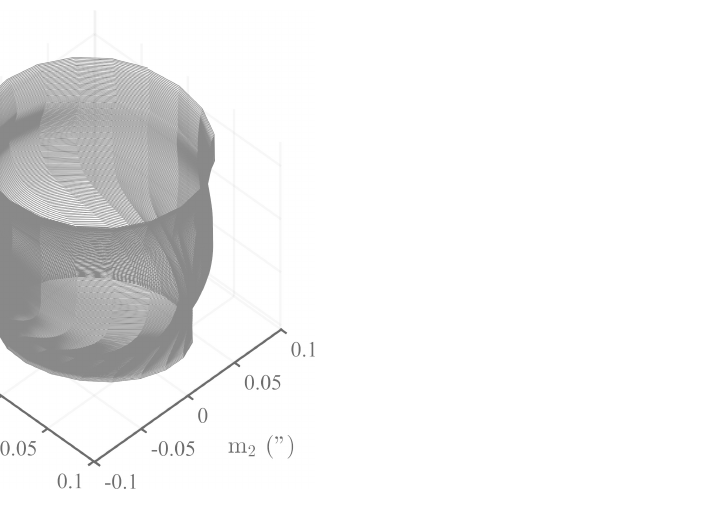
Figure A1. Spatio temporal evolution of the annual component of the rotation pole: ( a ) Lissajou pattern of the m 1 vs. m 2 coordinates of the iSSA annual component of the rotation pole; ( b ) same as in ( a ), with the added dimension of time